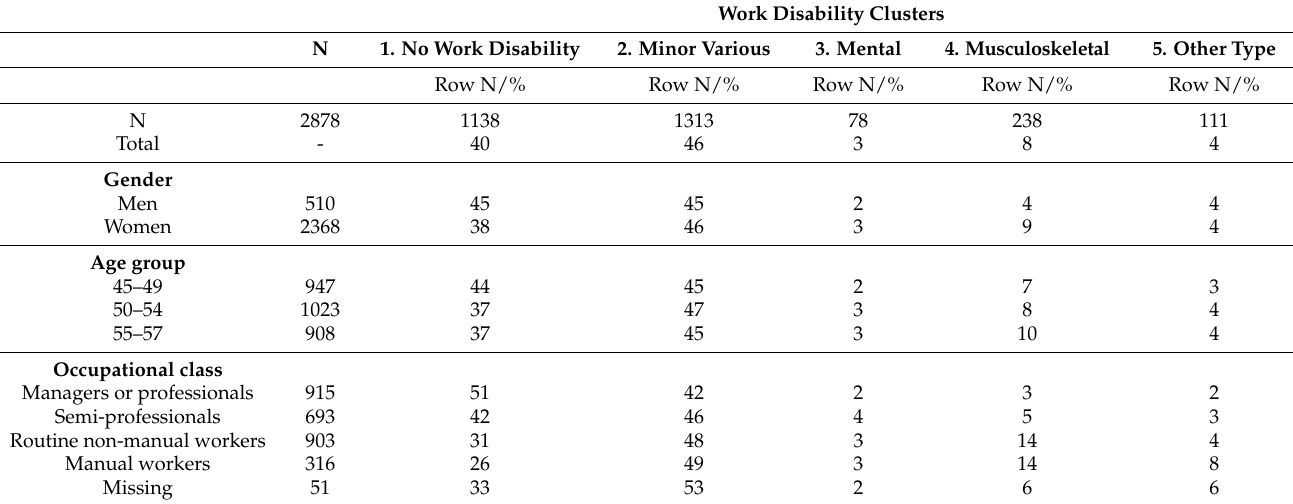
Figure 1. The five identified work disability clusters after submitting the 2007 survey in the Finnish Helsinki Health Study cohort ( n = 2878). Mean cross-sectional distribution of work disability states in the follow-up. Yellow = no work disability, purple = Musculoskeletal work disability (M00–M99), green = mental work disability (F00–F99), sand = other work disability. Table 1. Characteristics of the population and the identified work disability